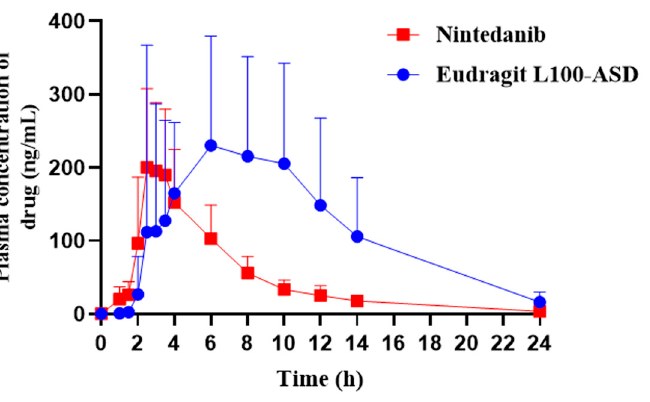
Figure 13. Mean plasma concentration–time curves of nintedanib after the oral administration of nintedanib and Eudragit L100–ASD in rats at a dose of 50 mg/kg (mean ± SD, n = 6). Table 2. The main pharmacokinetic parameters of nintedanib after oral administration of nintedanib and Eudragit L100–ASD in rats at a dose of 50 mg/kg ( n = 6). Parameters